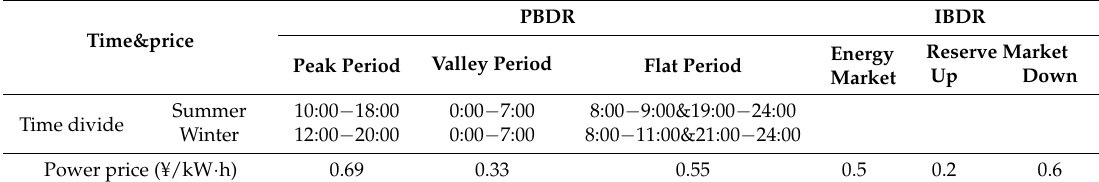
Table 1. Parameters of PBDR and IBDR in typical load day.